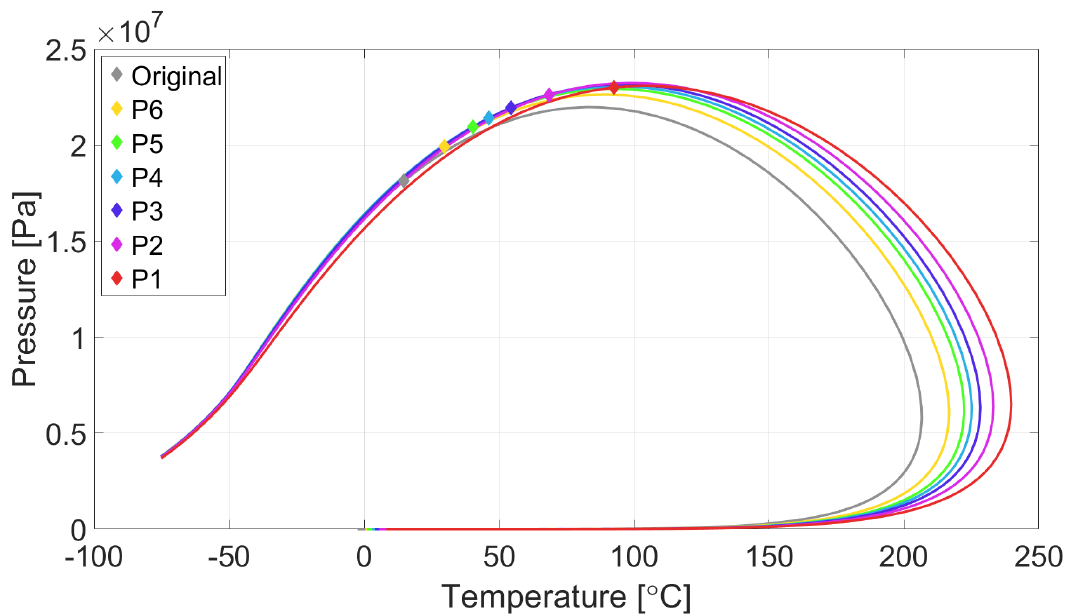
Figure 11. Phase envelope shift due to liquid